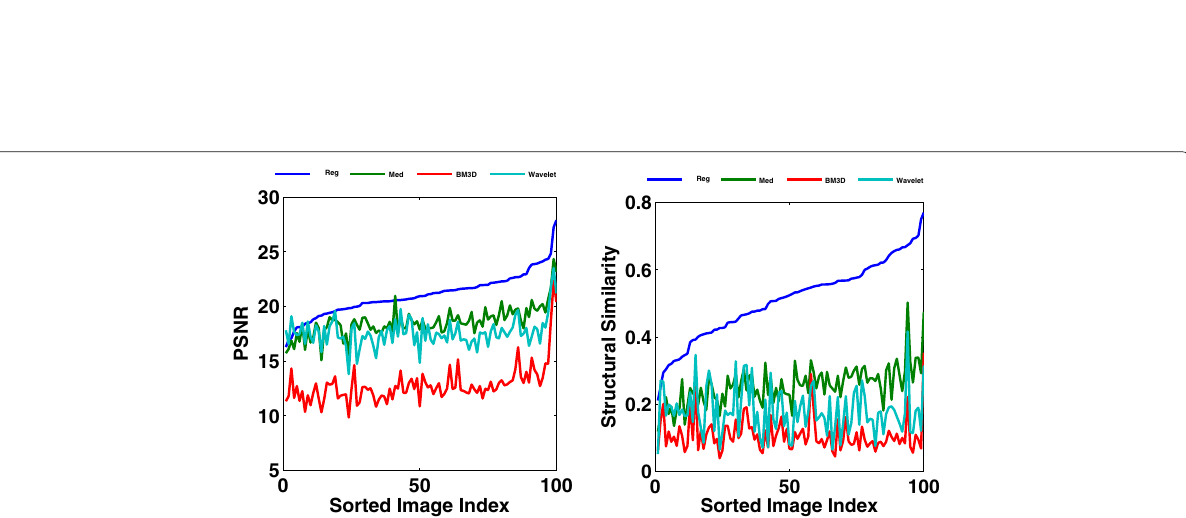
Fig. 14 One-hundred sample images denoised using our L 2 regression filter, median, BM3D, and wavelet filters with 50% of stripped noise